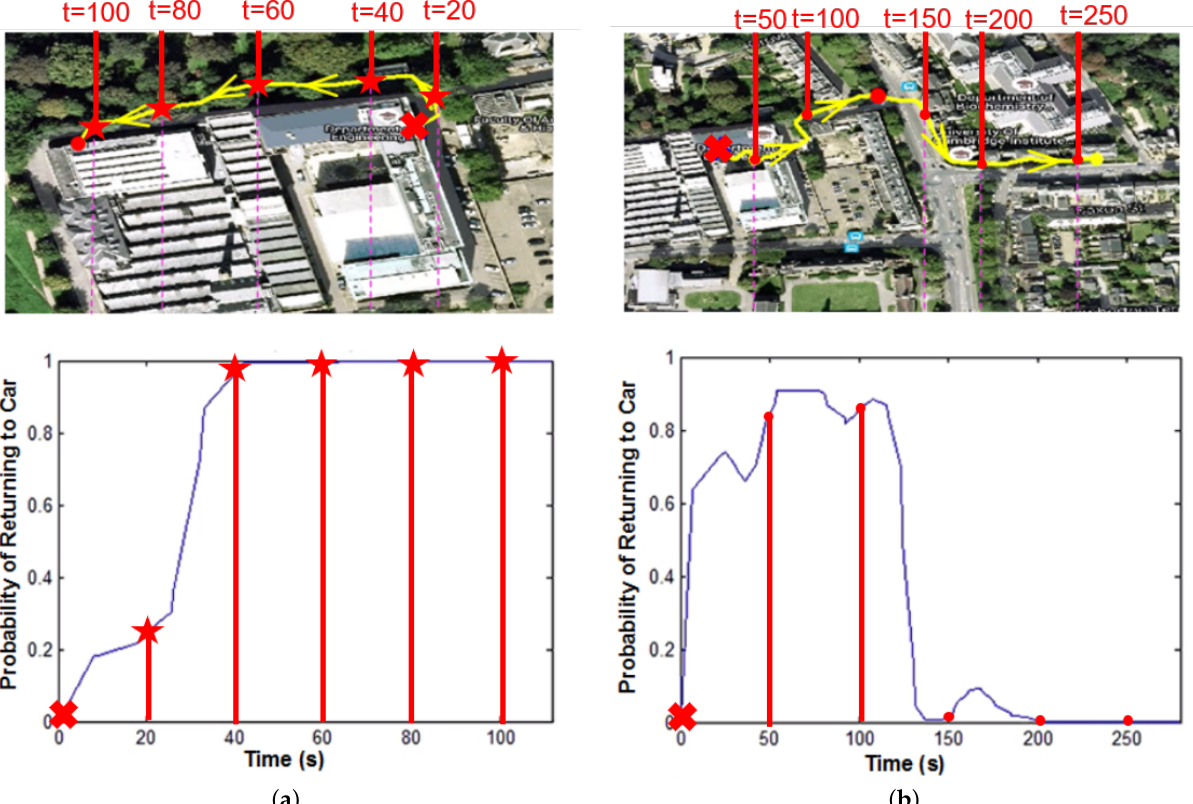
Figure 16. Inference results for the two scenarios, where the user walk back/past the vehicle, with respect to time in seconds. In box pictures, the car is marked as a red circle and the trajectory of the walked track is displayed in yellow. The direction of travel is indicated in the arrows. The red cross is the starting point and selected timestamps of the GPS trajectory are marked with stars. The graphs show the corresponding destination prediction as a function of time, that is, the probability that the user is returning to the vehicle. ( a ) First scenario where the driver returns to the car. ( b ) Second scenario where the driver walks past the car without returning to